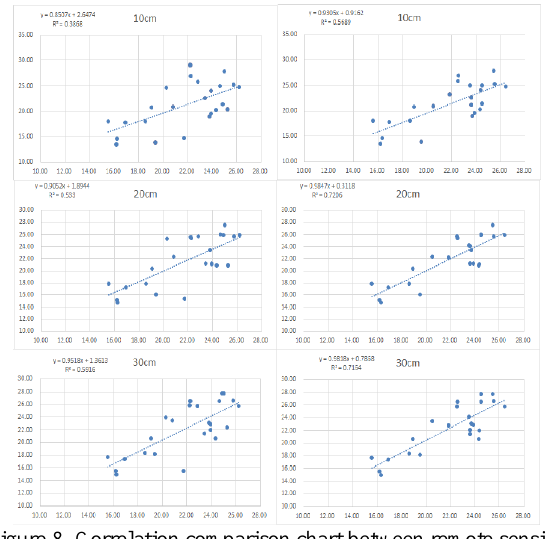
Figure 8. Correlation comparison chart between remote sensing inversion result of soil moisture and ground measured values based on pixel scale and land parcel unit scale on April 20, 2015 Note: Soil layer of depth 10cm, 20cm and 30cm, left figure shows correlation between pixel value and ground measured value; right figure shows correlation between land parcel unit and ground measured value.